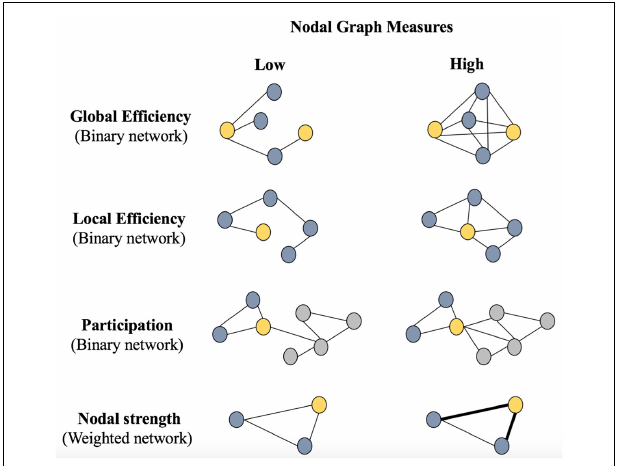
FIGURE 1 | Schematic representation of nodal graph measures. Circles represent nodes and edges represent connections between the nodes. The Global Efficiency panel represents a less efficient connectivity between the two yellow nodes (left: two steps between yellow nodes) vs. a more efficient connectivity between the two yellow nodes (right: multiple connections of one and two steps between yellow nodes). The Local Efficiency panel represents a less efficient connectivity between the yellow node and all other nodes (left: only one connection) vs. a more efficient connectivity between the yellow node and all other nodes (right: four connections). The Participation panel represents two communities (blue and gray); the yellow node belongs to the blue community and has less connections (edges) with the gray community in the left part of the panel (low participation) than in the right part of the panel (high participation). The nodal strength panel represents the intensity of the connectivity of the yellow node with its connections, where thinner connections (left) represent a lower strength and thicker connections (right) represent a higher strength. Parentheses indicate whether binary or weighted networks were used for each nodal measure.